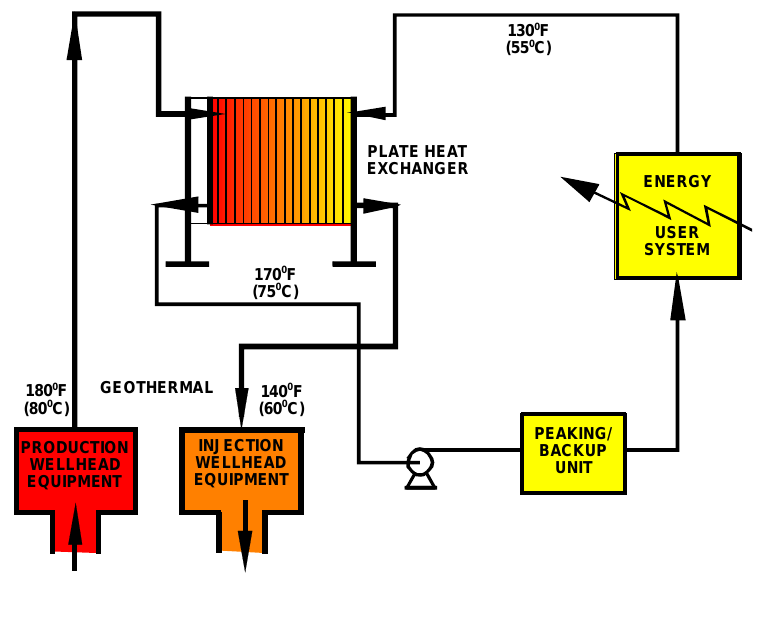
Figure 8. Geothermal direct-utilization system using a heat